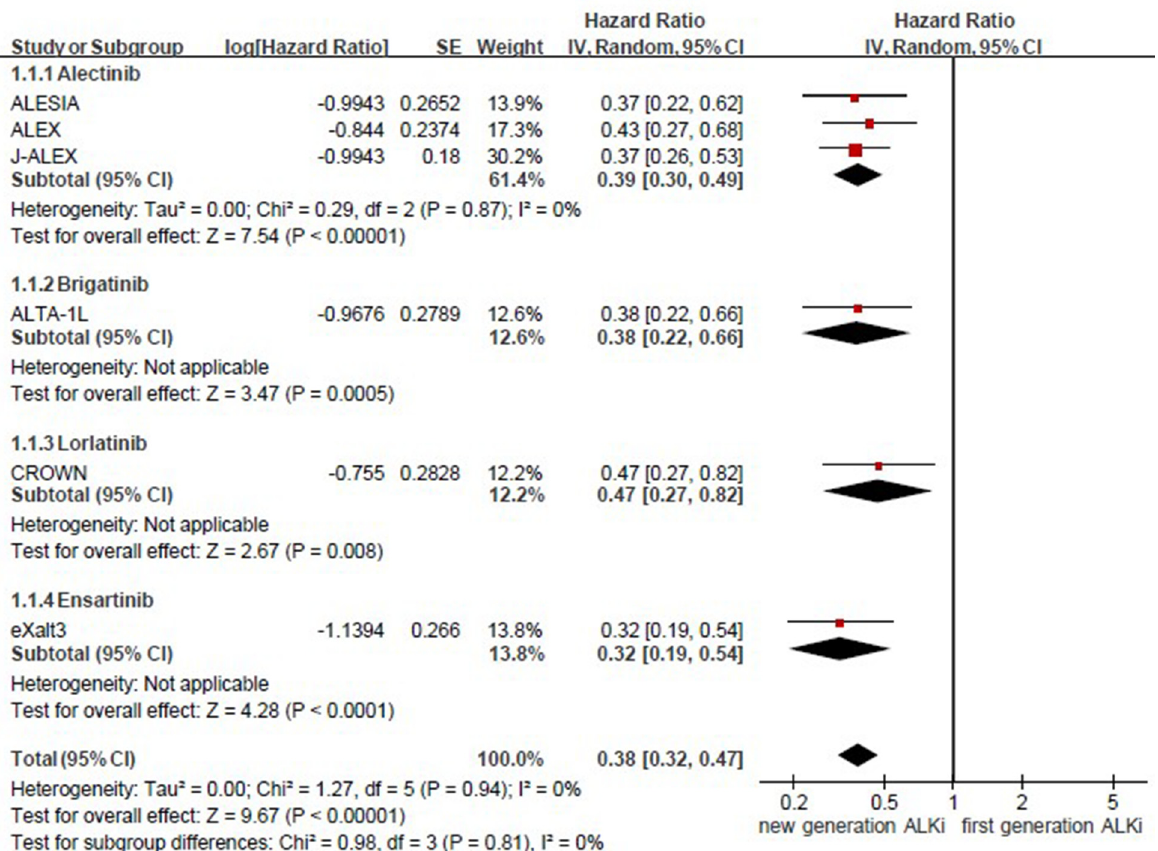
Figure A2. Forest plot and pooled hazard ratio for progression free survival (PFS).